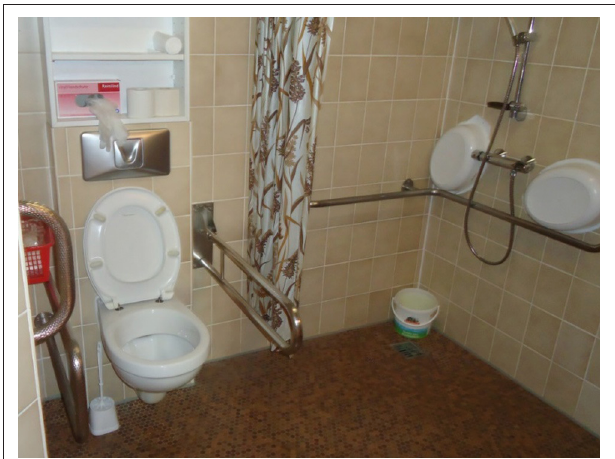
FIGURE 2 | A shared private bathroom of two residents, taken by Artner 2015.